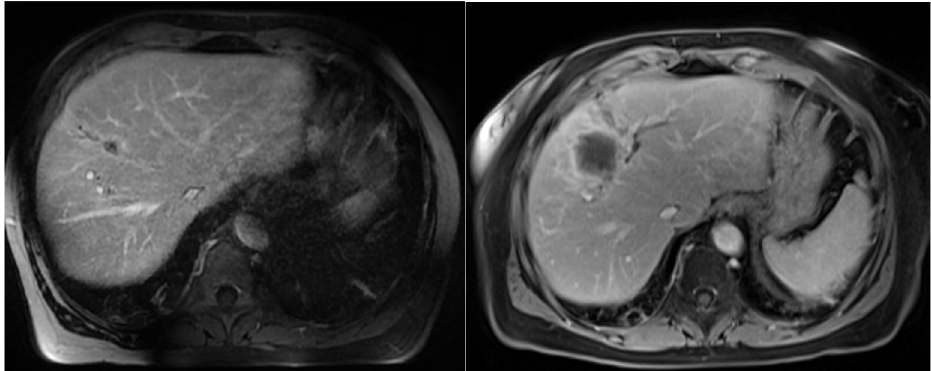
Figure 3. Local relapse: Example of a 15 mm MRI ( left image) liver metastasis from pancreatic tumor treated by stereotactic MRgRT (50 Gy in 5 fractions). On the ( right image), T1 portal gadolinium- enhanced MRI sequence shows a massive local recurrence 6 months after MRgRT.